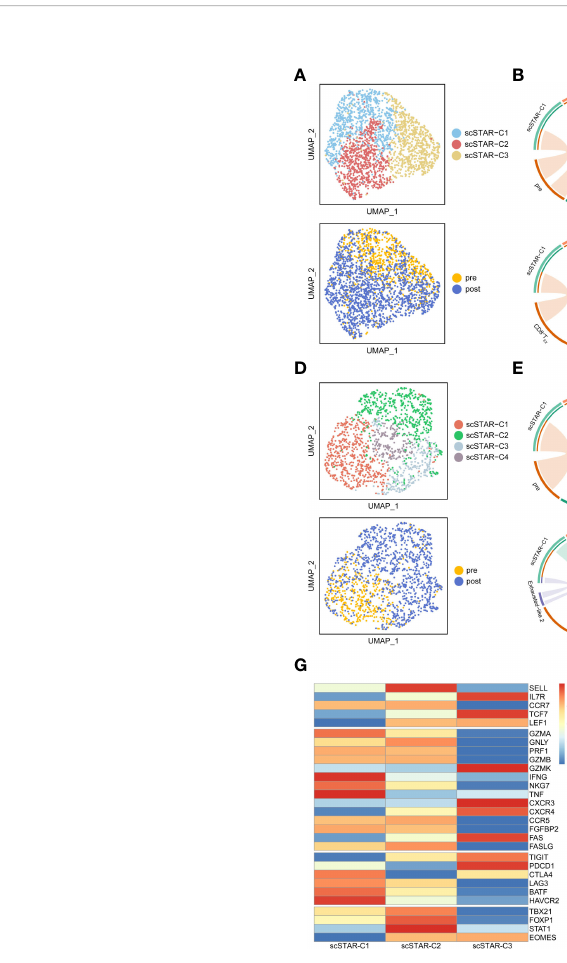
FIGURE 4 Molecular functional dynamics of CD8 + T cells and CD8 + T CM cells. (A) UMAP of CD8 + T cells processed by the scSTAR algorithm, colored by sample and cluster. (B) The association between scSTAR clusters and treatment (above) or CD8 + T cell subclusters (down) in CD8 + T cells. The area of the ties represents the relative enrichment. (C) Trajectory analysis for the three scSTAR clusters of CD8 + T cells. Each point corresponds to an individual cell colored by cluster (above) or by sample (down). The density curves represent the distribution of each cluster. (D) UMAP of CD8 + T CM cells processed by the scSTAR algorithm, colored by sample and cluster. (E) The association between scSTAR-processed clusters and treatment (above) or CD8 + T CM cell subclusters (down) in CD8 + T CM cells. The area of the ties represents the relative enrichment. (F) Trajectory analysis for the four scSTAR clusters of CD8 + T CM cells. Each point corresponds to an individual cell colored by cluster (above) or by sample (down). The density curves represent the distribution of each cluster. (G) Heatmap of scaled normalized expression for scSTAR cell function genes in CD8 + T cells. (H) Heatmap of scaled normalized expression for scSTAR cell function genes in CD8 + T CM